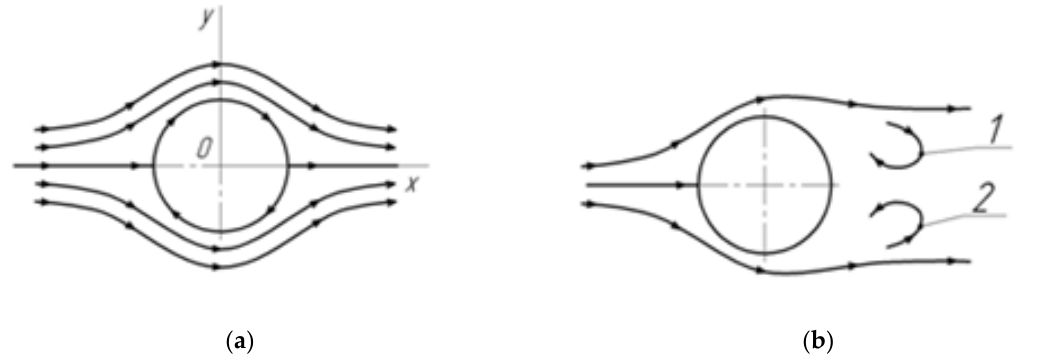
Figure 3. Air flow around the non-working and working surfaces of the drum and pulley rim: ( a ) non-circulating; ( b ) circulating; 1, 2—inside different directions [25].